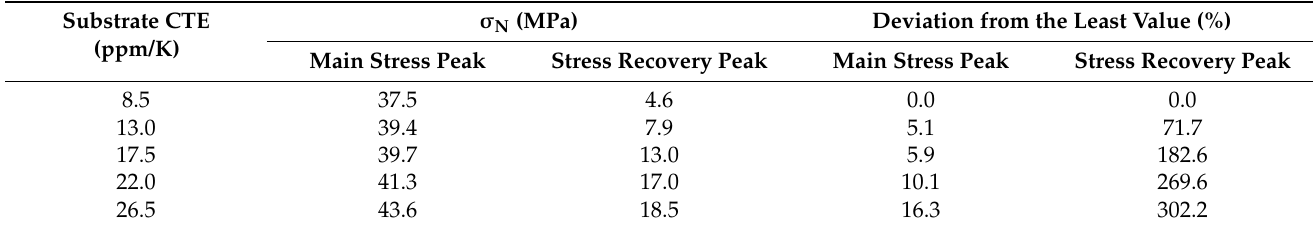
Figure 9. The variation of N-point stress along with the change of substrate CTE values. Table 3. Magnitude and deviation in N-point stress values under non-fixed